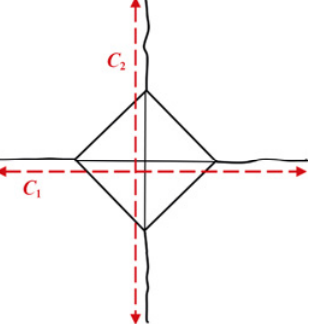
Fig. 1 Diagram of Vickers hardness